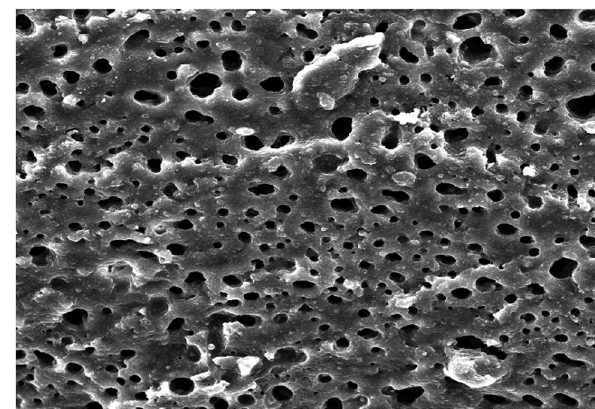
Figure 10: Micrograph of the upgraded covering material with HDPE - reinforced energy curtains.